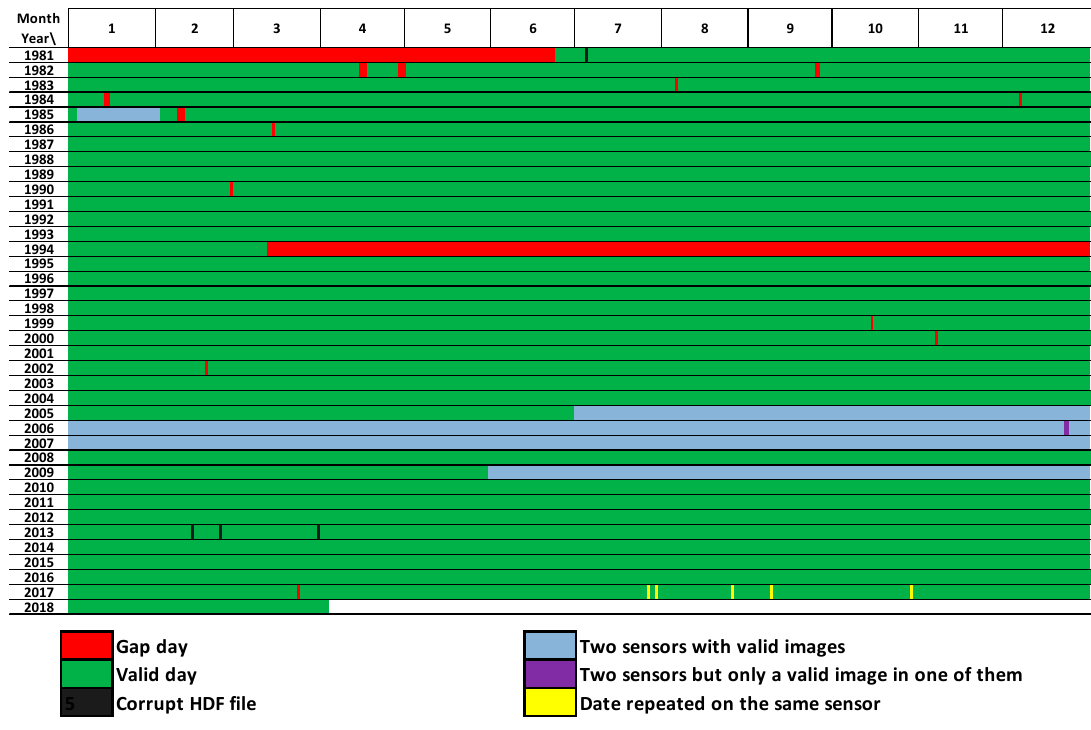
Figure 2. Global and daily data availability of LTDR (v5) in the time series where it was possible to find different problems such as gaps without data (as in 1994 with an eight-month gap or specific gaps in the time series), several daily images with more than one sensor, and corrupt or repeated files.